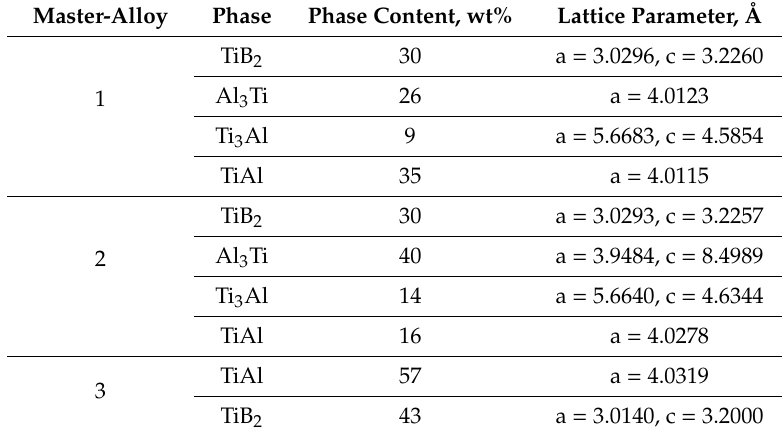
Figure 4. X-ray di ff raction diagram of the MA3. Table 1. Compositions of master